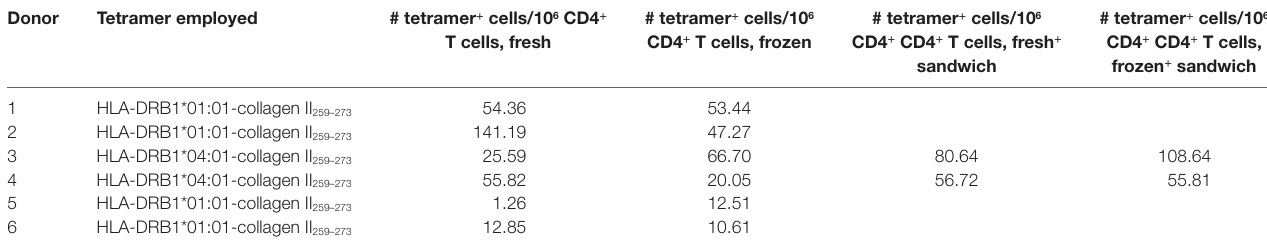
tAbLe 1 | Overview number of detected collagen II-specific CD4 + T cell in fresh and frozen samples. donor tetramer